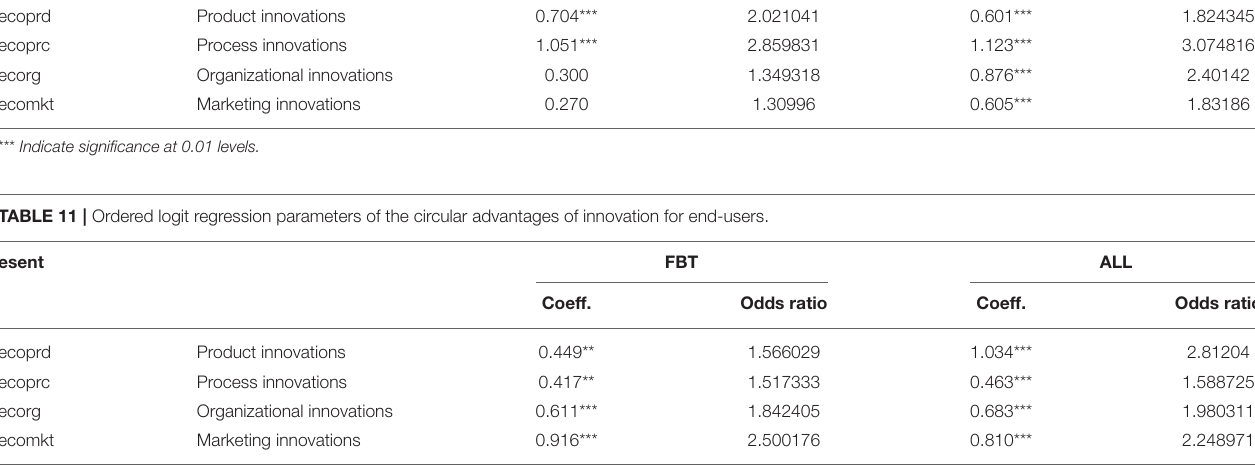
TABLE 10 | Ordered logit regression parameters of the circular advantages of innovation for enterprises. esent FBT ALL Coeff. Coeff.